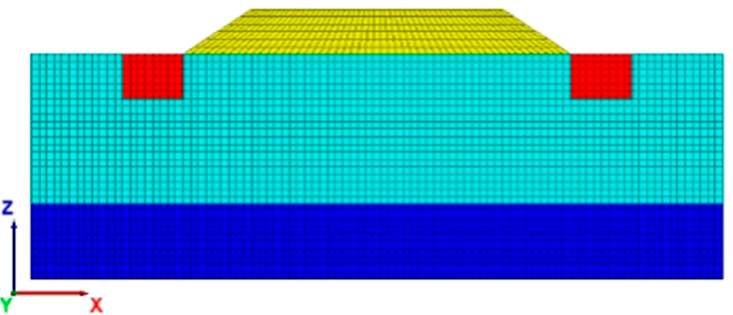
Figure 6. Numerical calculation model of ELB.